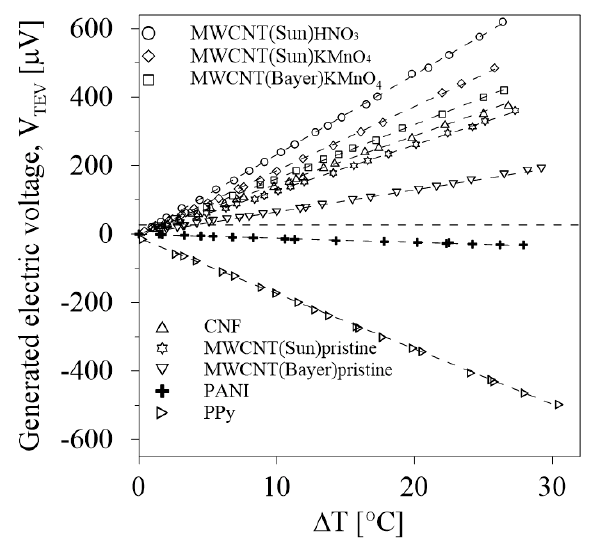
Figure 8. The relations between generated voltage and temperature difference for all investigated EOC composites.